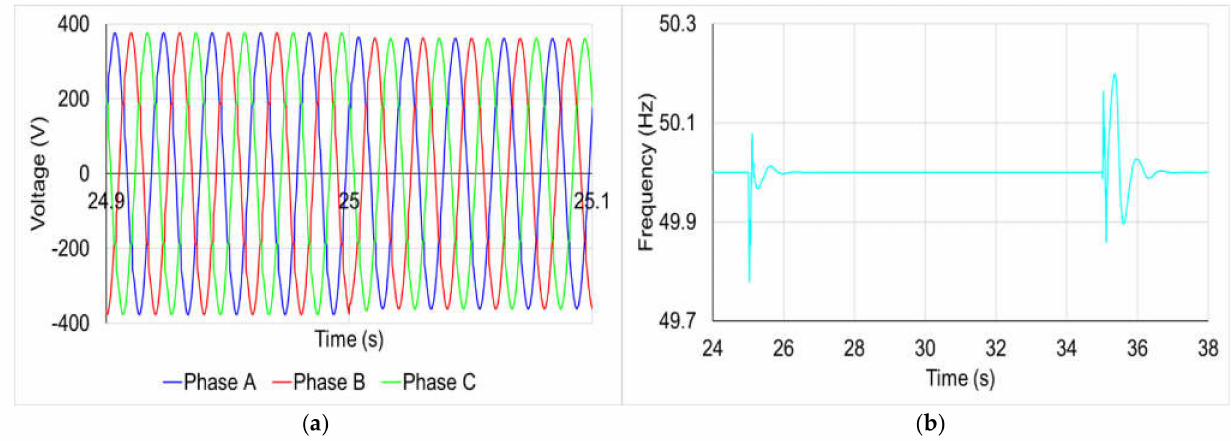
Figure 12. ( a ) AC Voltage. ( b ) Frequency fluctuations.